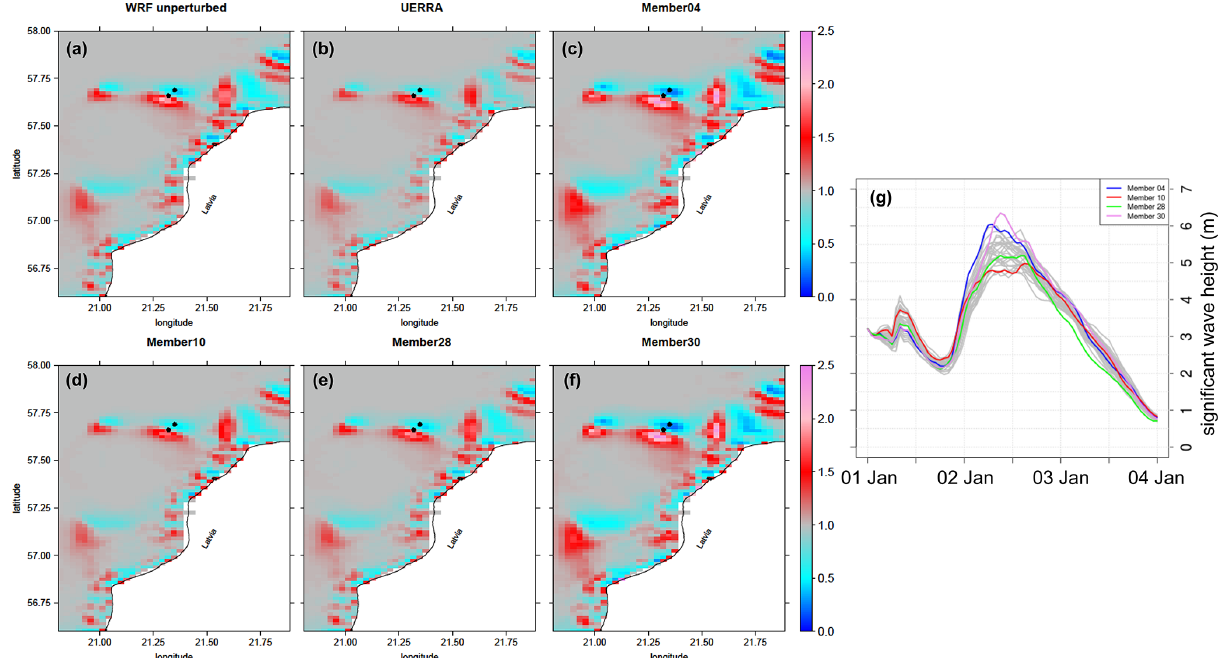
Figure 7. Seabed concentration of PVC with a 330µm diameter on 3 January 2019 at 12:00UTC, i.e. after the storm surge event in the model, relative to the homogenous initial concentration. Individual panels show the unperturbed WRF run (a) , the model driven by UERRA/HARMONIE-v1 (b) , and four selected WRF ensemble members (c–f) . Dots show the locations of the grid cells selected in Fig. 6. (g) Time series of the significant wave height [m] at the position of the dot in the other figures with net erosion.